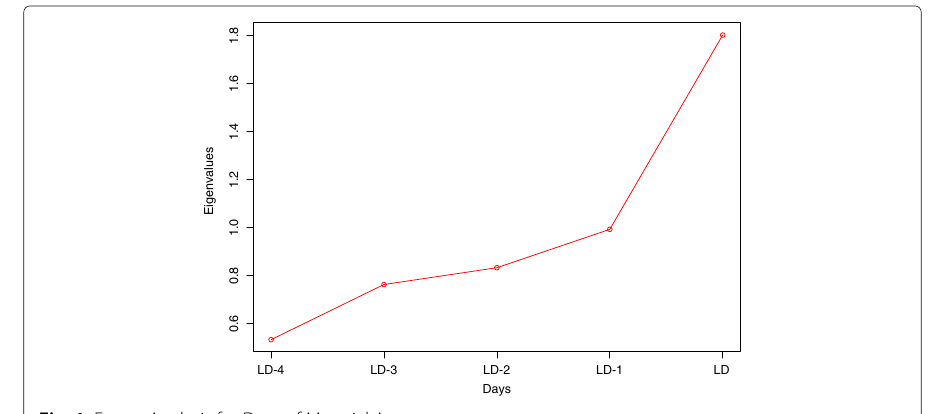
Fig. 1 Factor Analysis for Days of Material